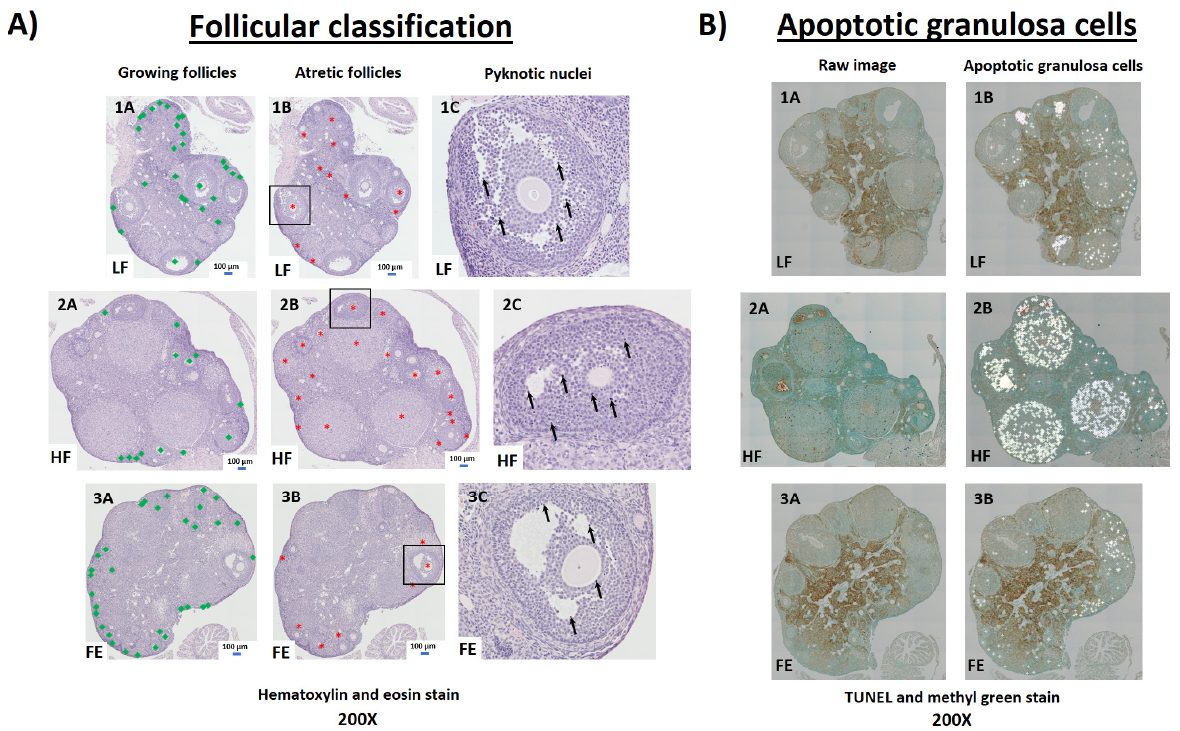
Figure 9. Ovarian follicular pathology by hematoxylin and eosin (H&E) and TUNEL staining. ( A ) Four consecutive, ovarian paraffin-sections (5 µm) per animal were stained with H&E and imaged via light microscopy for follicular pathology (200 × ). All follicles, including primary, secondary, early antral, and antral (e.g., excluding primordial follicles and corpus luteum) were counted and categorized as either growing (A; green squares) or atretic (B; red stars). Follicles containing dark, pyknotic nuclei within the granulosa cells were considered atretic (C; arrows). ( B ) One ovarian paraffin-section (5 µ m) per animal was stained via terminal deoxynucleotidyl transferase-mediated dUTP nick-end labeling (TUNEL) and imaged via light microscopy to identify apoptotic granulosa cells (200 × ). LF = Low Fat Diet (Panel 1), HF = Western Diet (Panel 2), FE = Fertility Enhancer Diet (Panel 3).